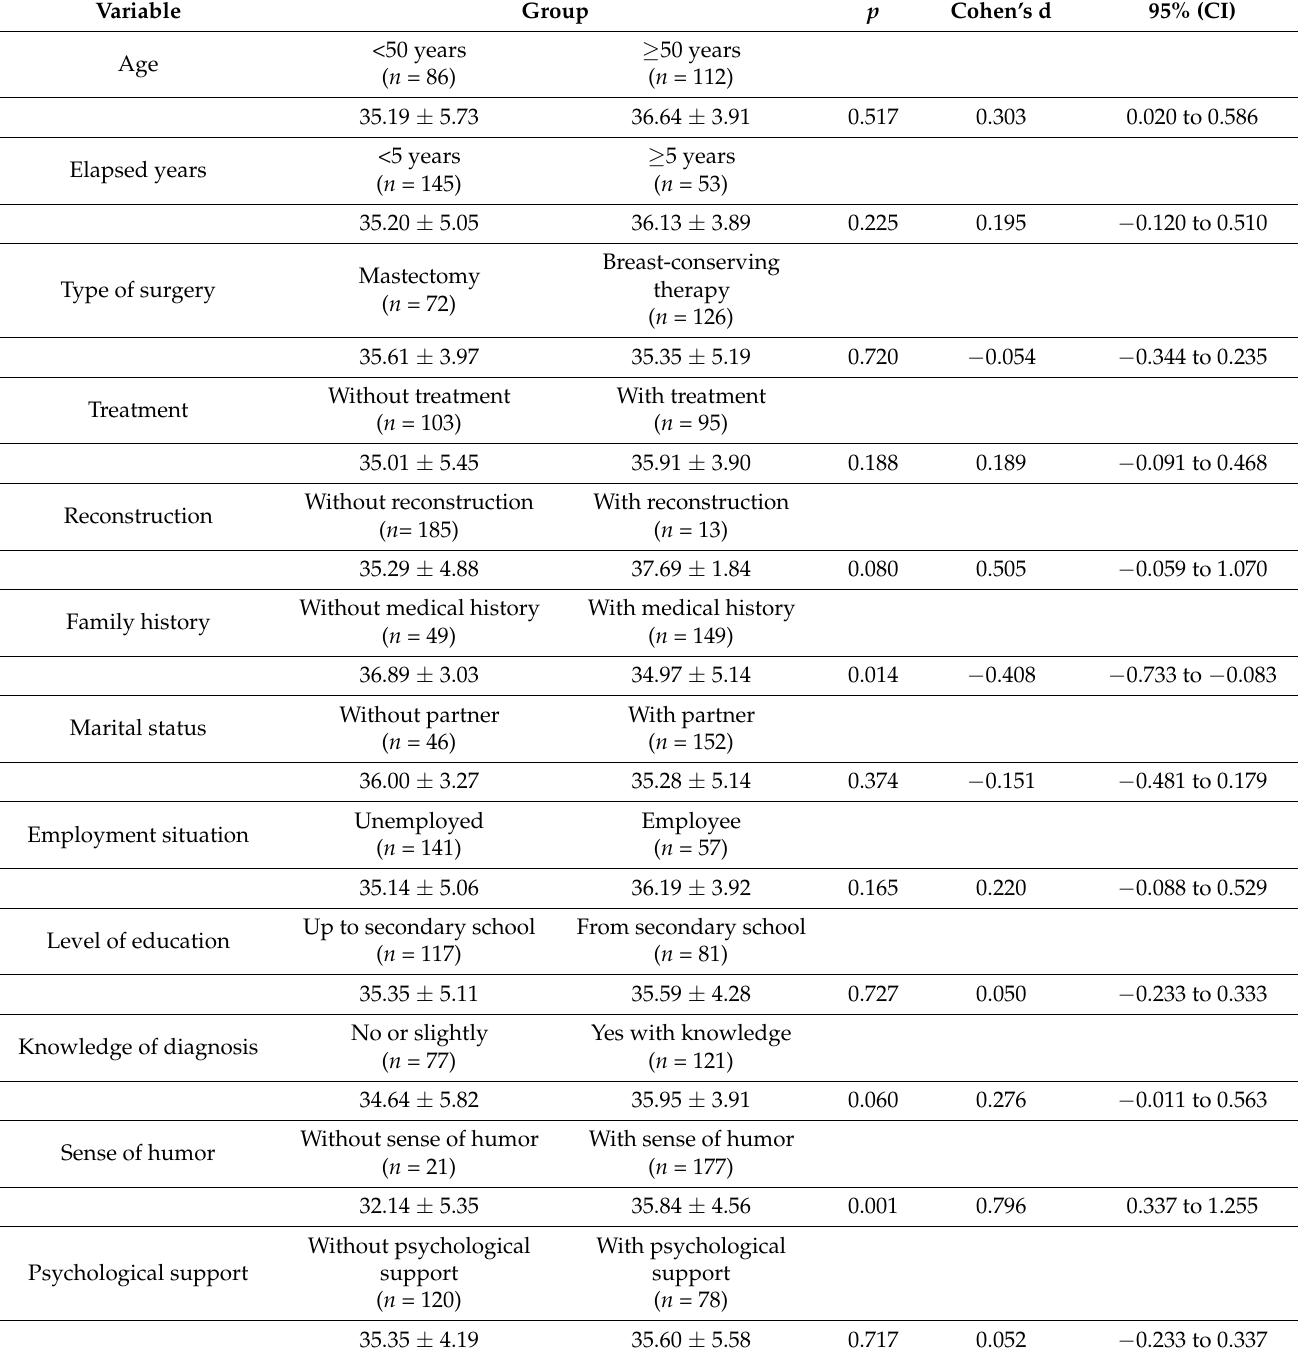
Table 2. Association between Characteristics and Self Esteem in Breast Cancer Survivors